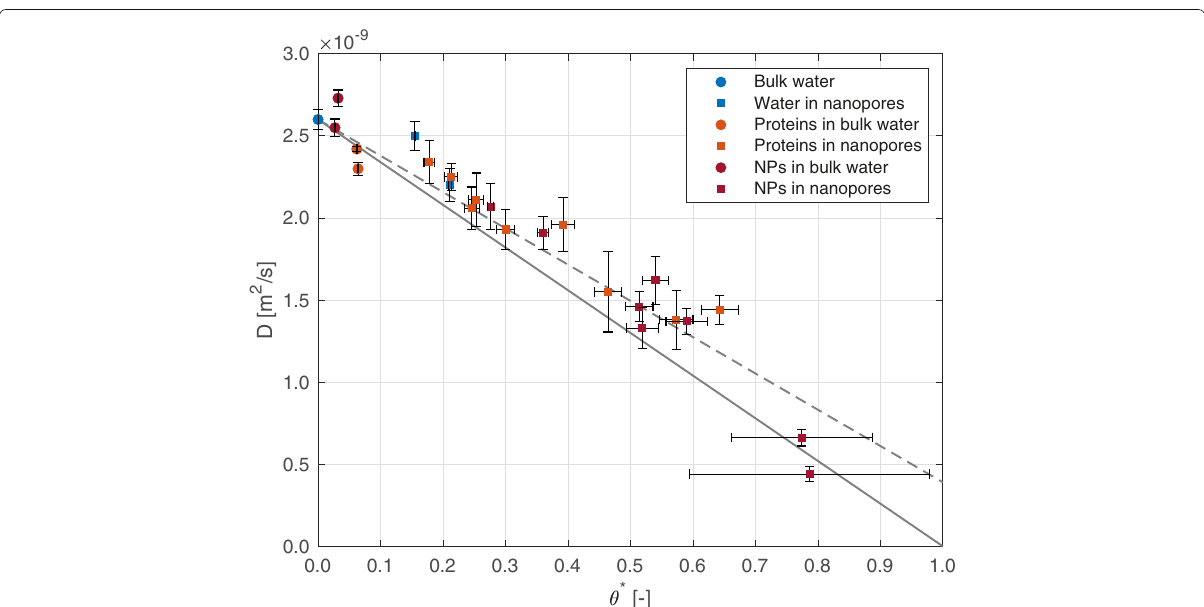
Fig. 2 Water self-diffusion coefficient for different systems. The self-diffusion coefficient of water is shown against the scaling parameter θ ∗ for different systems. Data for proteins in silica nanopores have been obtained via molecular dynamics, while the rest of the data from the Supplementary information in [24]. In the legend, nanoparticles are abbreviated as NPs. The uncertainties on the value of D refer to the fitting of the mean square displacement ( ± 1 s.d.); the uncertainties on the value of θ ∗ to the estimate of the total volume accessible to water molecules ( ± 1 s.d.). The solid and dashed lines report the model in Eq. (1) in case of D C = 0 and D C = 0.39 × 10 − 9 m 2 / s,